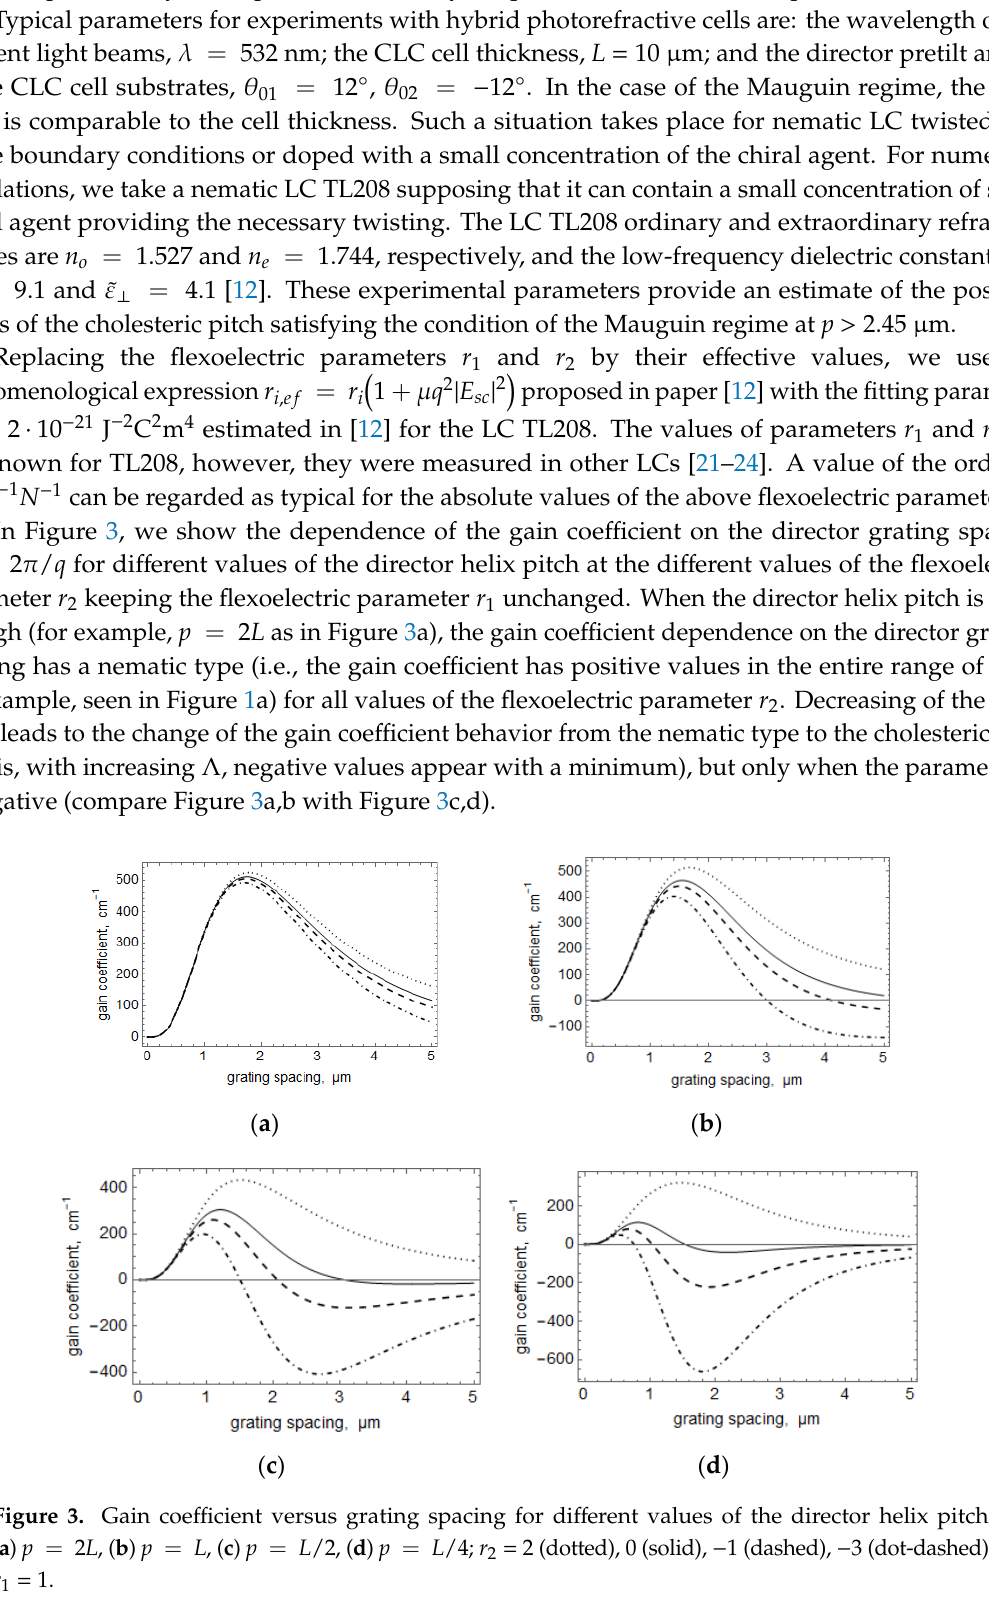
( b ) Figure 4. Influence of the flexoelectric parameter 1 r on the gain coefficient. ( a ) p L = , ( b ) / 4 p L = ; 1 r = 1 (solid), 2 (dashed), 3 (dot-dashed); 2 r = − 3. In our theory, beams coupling and gain of the signal beam are determined by the interaction of the photorefractive field with the LC flexopolarization